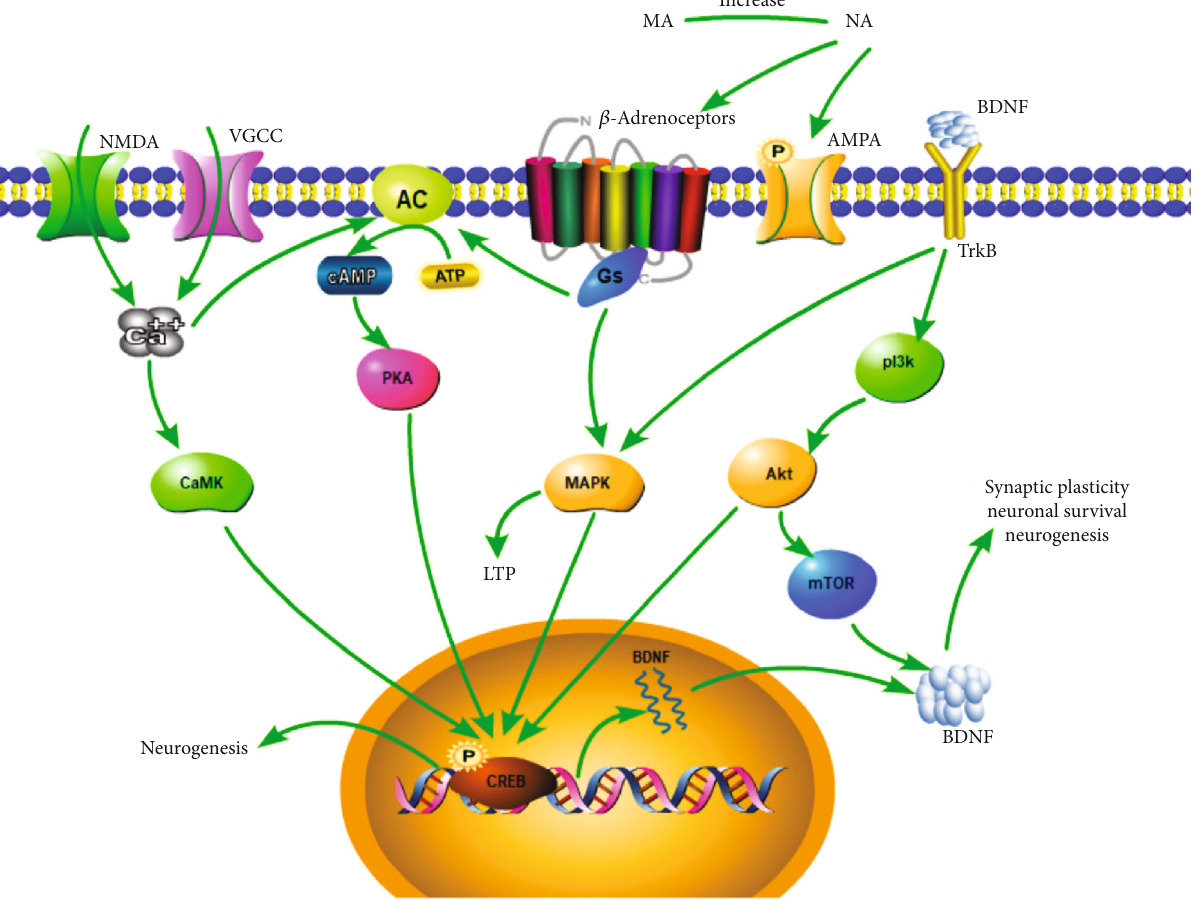
Figure 4: Role of β -adrenoceptors on antidepressant e ff ect. All arrows indicate activation arrows. Gs: stimulating adenylate cyclase g protein; ATP: adenosine triphosphate; AC: adenylate cyclase; cAMP: cyclic adenosine monophosphate; PKA: protein kinase A; CREB: cAMP- response element-binding protein; BDNF: brain-derived neurotrophic factor; LTP: long-term potentiation; AMPA: α -amino-3-hydroxy-5- methyl-4-isoxazole propionate receptor. Table 2: LD of mesaconitine. 50